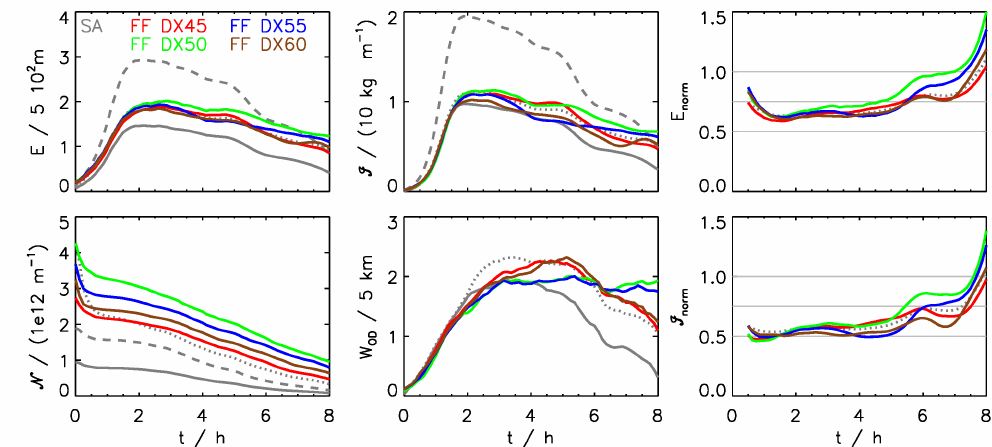
Figure 9. Temporal evolution of various contrail-cirrus properties are displayed for formation flight geometries with different lateral offset DX (ranging between 45m and 60m as indicated by the labels). The first two columns shows absolute values of total extinction, total ice crystal mass and number, and contrail width (analogous to Figure 5). The right-most column shows normalised values of total extinction and total ice crystal mass (analogous to Figure 7). The grey lines show the reference simulation REF (solid), 2 * REF (dashed) and NNN (dotted). The synoptic scenario is given by w05_dT2K_s2 and RH i,0 ∗ = 110% (see Table